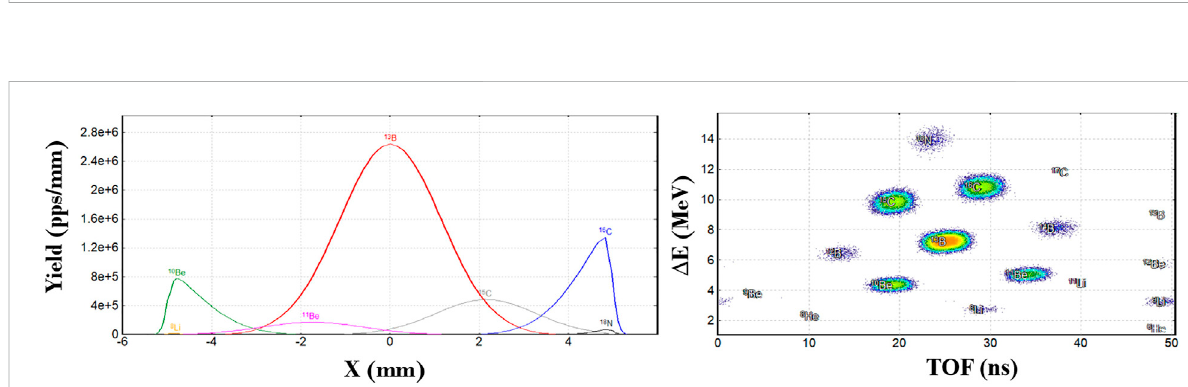
FIGURE 8 Simulatedspatial distributionattheexit ofthefragment separatoron thehorizontaldirection(left)and simulated Δ E-TOF taggingplot (right), in thecase of 18 O 8+ at70 AMeVprimary beamandforatuningofthefragment separator maximizingthe 13 Bproduction.Forthesakeofclarity,onlythe main contaminants are shown in the spatial distribution